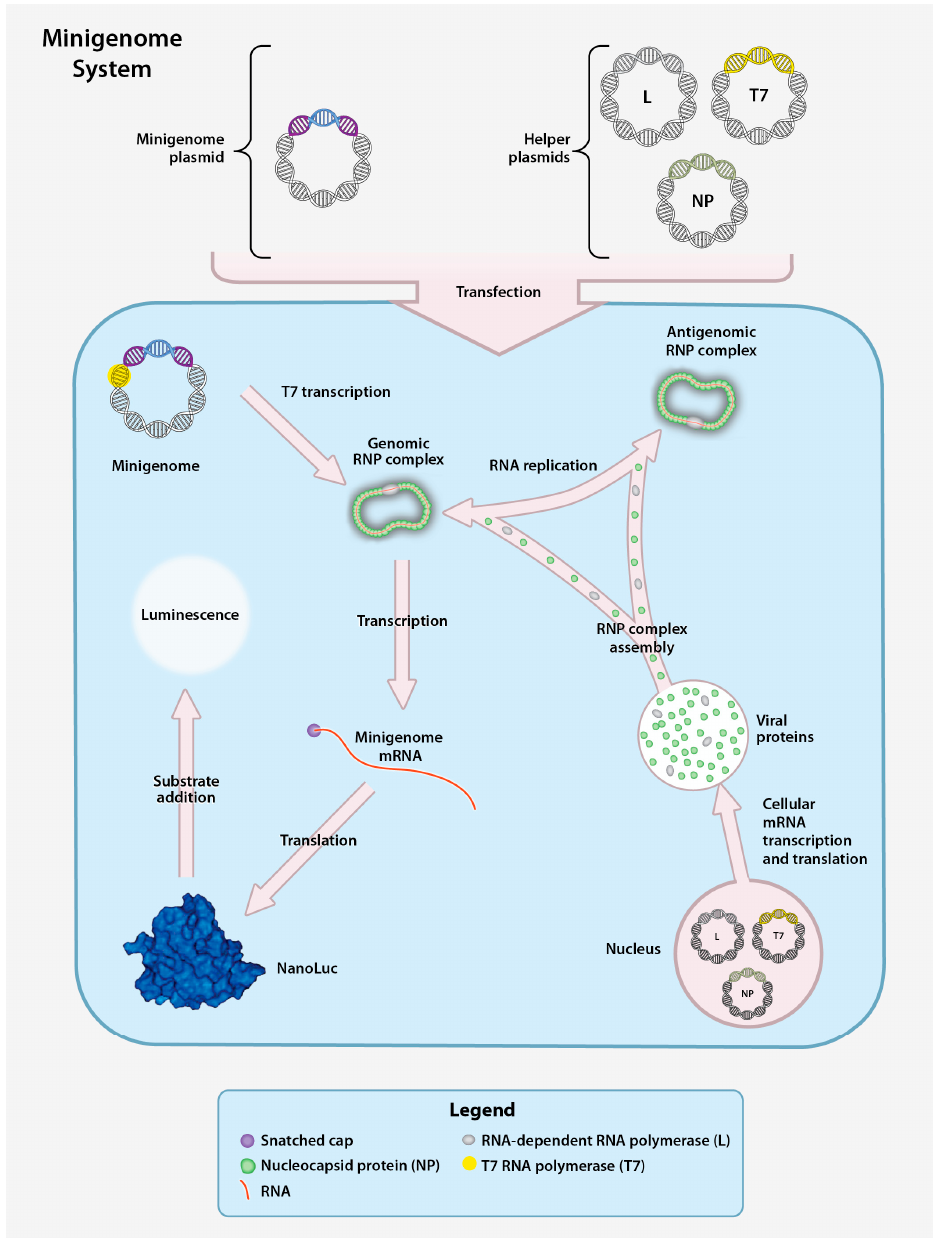
Figure 5. CCHFV minigenome system. The CCHFV minigenome system is composed of a plasmid